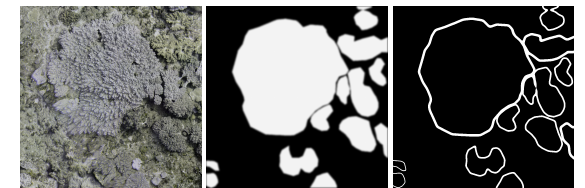
Figure 6. A dataset tile (Left), the probability map (Center), cross-entropy mask (Right)